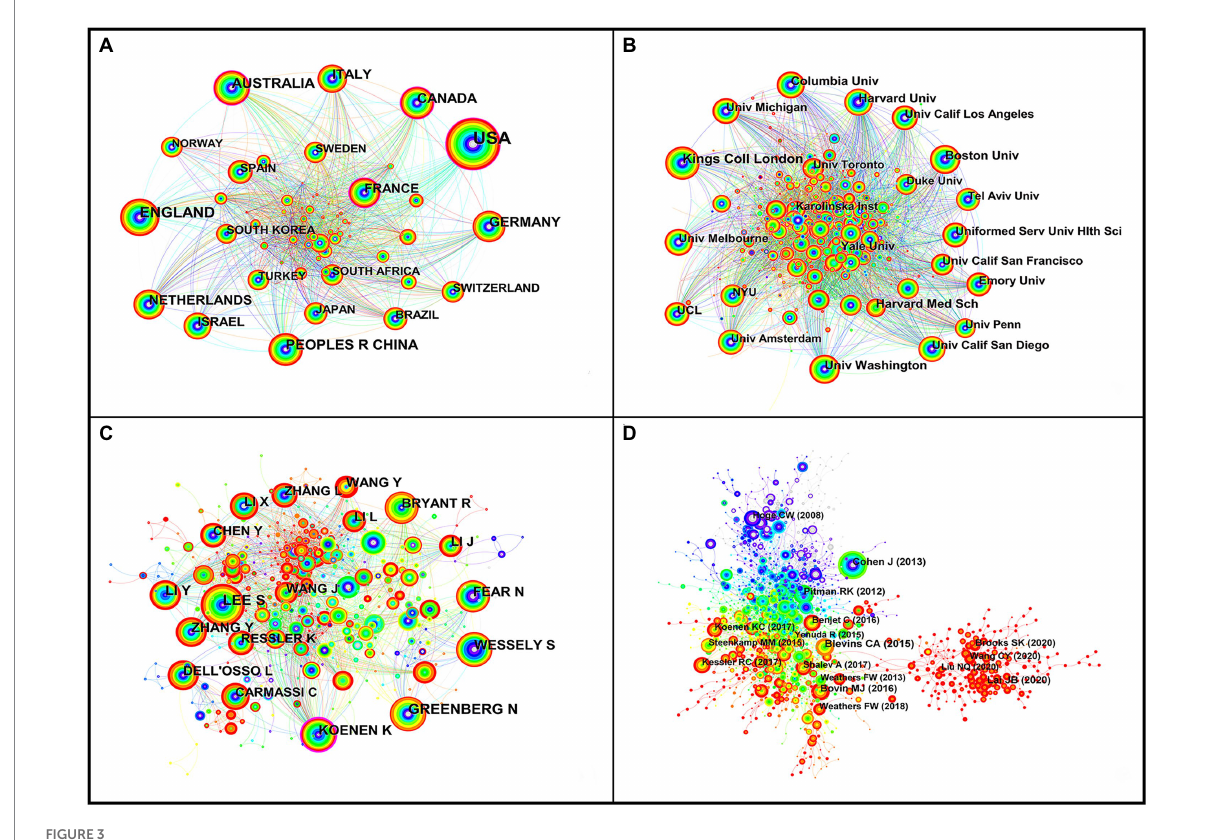
FIGURE 3 The bibliometric analysis. (A) primary countries or regions; (B) primary institutions; (C) leading authors and prolific authors; (D) literature co- citation. The nodes size represents the quantity of papers (A–C) or co-citation (D) ; the purple outer circle nodes indicate that the number of studies in countries or regions (A) or institutions (B) or authors (C) or co-cited literature (C) may continue to increase, and nodes with orange or gray outer circles indicate that they has received attention in the past, but is no longer hot spots; the thickness of the line between the nodes represents degree of connection (A–C) or co-citation (D) ; the warmer the color of the line, the closer the interconnection time.